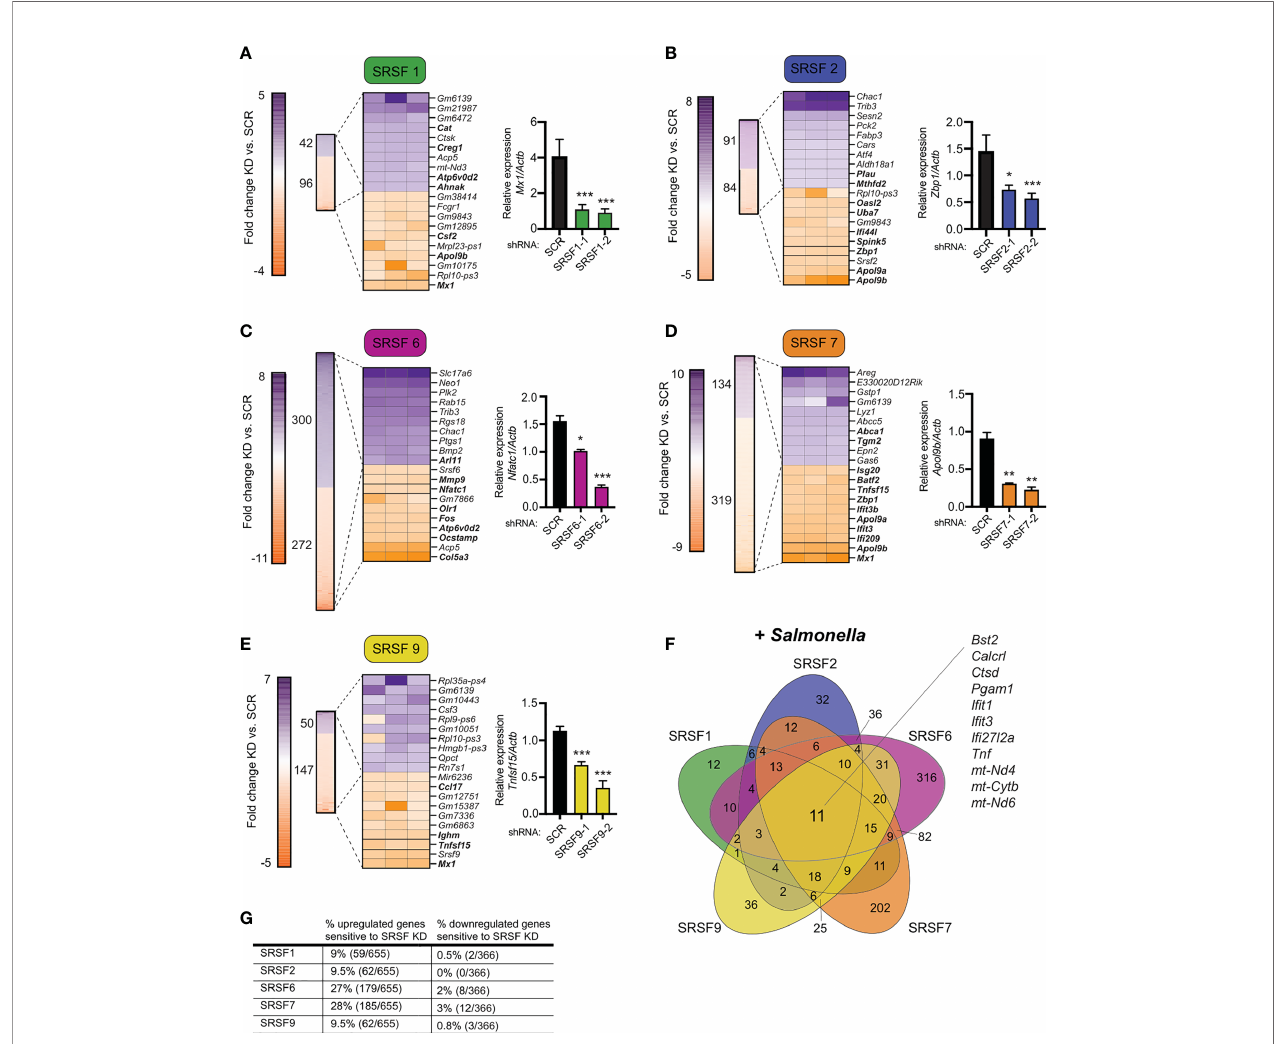
FIGURE 3 | Knockdown of SR family members causes both up- and down-regulation of gene expression in Salmonella -infected macrophages. (A) On left, heatmap represents all up- and down-regulated genes in SRSF1 knockdown RAW 264.7 macrophages relative to SCR control at 4h post- Salmonella infection (p<0.05). Numbers next to heatmap indicate the total number of up- (purple) or down- (orange) regulated genes in SRSF1 knockdown cell lines vs. SCR. Zoom in represents the top 10 up- and down-regulated genes. Genes whose expression is up- or down-regulated by virtue of Salmonella -infection itself (i.e. innate immune regulated genes) according to analysis of Salmonella -infected SCR vs. uninfected SCR cells are bolded. Box indicates gene chosen for RT-qPCR validation. On right, RT- qPCR validation of a representative DEG ( Mx1 ) in two SRSF1 knockdown cell lines vs. SCR control cells (data shown relative to Actb ). (B) As in (A) but for SRSF2; RT-qPCR of Zbp1 . (C) As in (A) but for SRSF6; RT-qPCR of Nfatc1 ; (D) As in (A) but for SRSF7; RT-qPCR of Apol9b; (E) As in (A) but for SRSF9; RT-qPCR of Tnfsf15 . (F) Venn diagram of DEGs common to one or more SR knockdown cell line (p<0.05). The 11 genes whose expression is impacted by loss of all fi ve SRSF proteins are highlighted. (G) Percentage of all genes induced at 4h post- Salmonella infection (>2.0-fold) that are differentially expressed in each SRSF knockdown macrophage cell line (p<0.05). For all RT-qPCRs, values are the mean of 2 or 3 biological replicates and error bars indicate standard deviation. *p < 0.05; **p < 0.01; ***p <